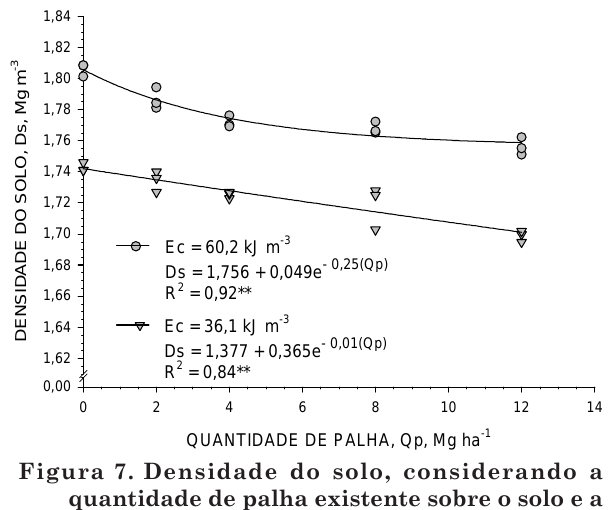
Figura 7. Densidade do solo, considerando a quantidade de palha existente sobre o solo e a energia de compactação usada no ensaio Proctor, para um Argissolo Vermelho-Amarelo arênico (** modelo ajustado é significativo a p ≤≤≤≤≤ 0,01 pelo teste